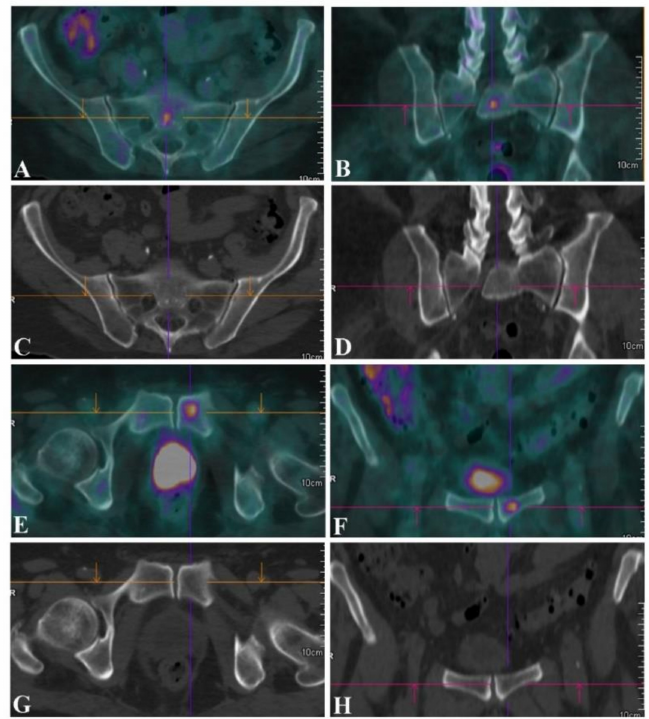
Figure 3. ( A , B ; SUV max = 7.1) 18 F-FDG PET / CT for initial staging in a patient with a rhabdomyosarcoma of the right thigh showing unexpected small FDG-avid bone metastases at the level of the sacrum ( A , B ; SUV max = 7.1) and of the left hemipubis ( E , F ; SUV max = 7.9), which were not associated with any osteostructural alteration at the ( C , D , G , H ) co-registered CT image. ( A , E ) Axial and ( B , F ) coronal 18 F-FDG PET / CT fused images of the sacrum and of the hip, along with the ( C , D , G , H ) corresponding CT